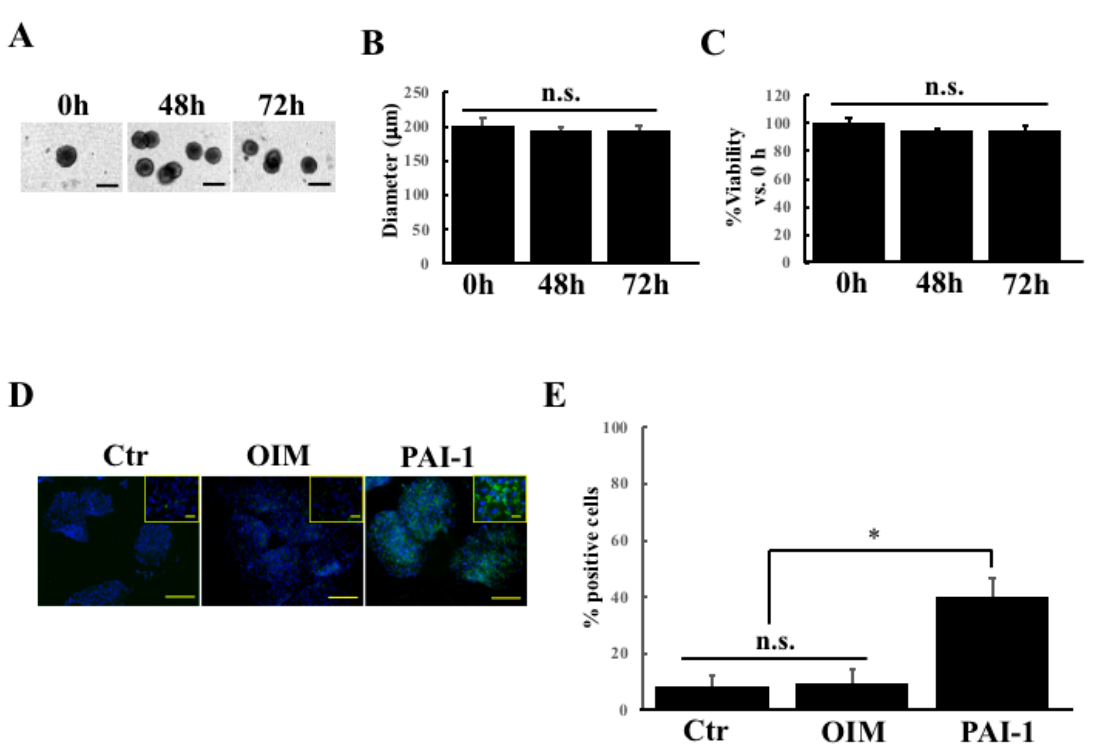
Figure 2. Effect of rhPAI-1 on the CEMP1 expression in the embedded HPLSC spheroids. ( A ) Phase- contrast images of the HPLSC spheroids at 0, 48, and 72 h after the embedded culture with DMEM. The scale bars represent 200 µ m. ( B ) Diameter measurements of spheroids at 0, 48, and 72 h after the embedded culture. The analysis was performed using WinROOF software and the data represent the mean ± SD of three independent experiments. n.s., not significant. ( C ) The cell viability of the spheroids was measured at 0, 48, and 72 h after the embedded culture as absorbance in the independent experiments with six replicates each. The results are expressed as a mean value ± SD percent optical density vs. 0 h spheroids. n.s., not significant. ( D ) Immunostaining images of CEMP1 (green) in HPLSC spheroids after a 2 day incubation with DMEM (control), OIM alone (OIM), or OIM containing rhPAI-1 (PAI-1). The nuclei were counterstained with DAPI (blue). The scale bars represent 100 µ m. Pictures at high magnification are shown in the insert. The scale bars represent 20 µ m. ( E ) Semiquantification of the percentage of positive cells that were stained with CEMP1 in the embedded HPLSC spheroids. The percentage (%) of positive cells was calculated by the number of positive cells/the number of whole cells in the spheroids using the WinROOF software. Data represent the mean ± SD of three independent experiments. * p <